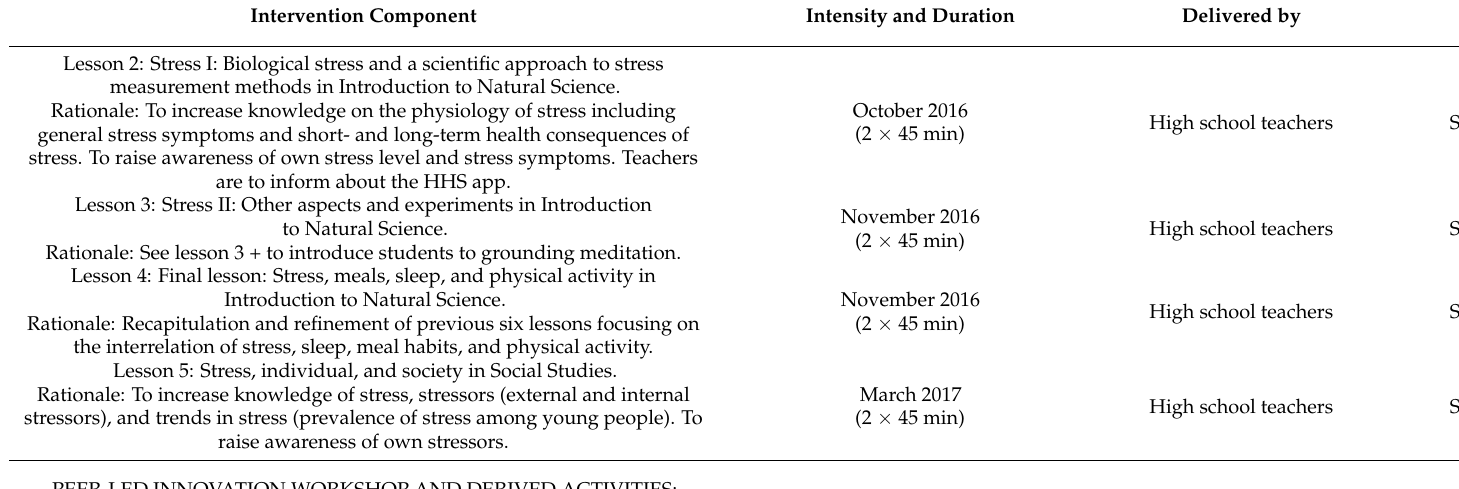
Modifiable Determinants of